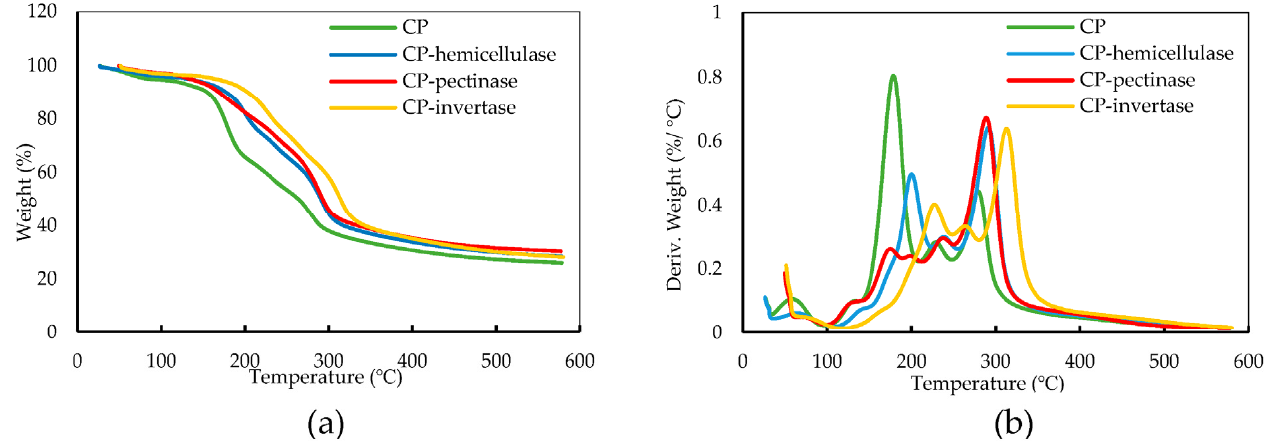
Figure 4. ( a ) Thermogravimetric analysis and ( b ) derivative thermogravimetric analysis of CP and the solid residue obtained after the enzymatic pretreatment.